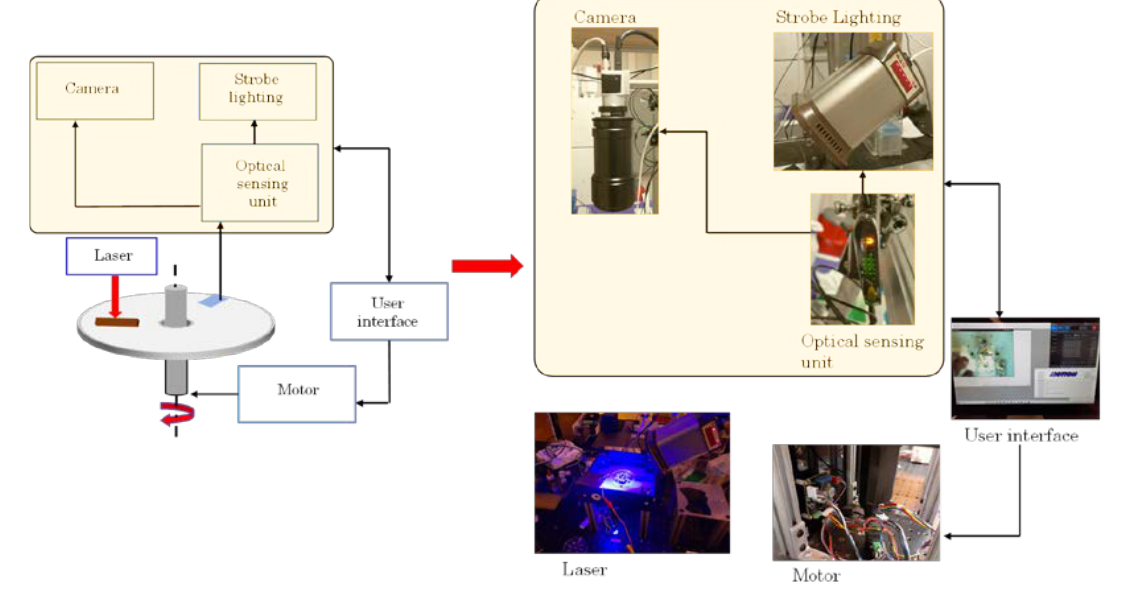
Figure 4. The experimental setup for testing the integrated CD consisting of the spin chuck that is spun by a motor and the motor is connected to the controller that gets its input for angular velocity and acceleration via graphic user interface on the computer. The optical sensing unit receives a laser light reflected from a piece of reflecting tape secured to the CD and this light serves as a signal to open the shutter to take a picture with digital camera and to shine the stroboscopic light to add illumination for taking the picture. This sequence of photographs (one per disc’s revolution) is recorded as a video that is captured from a computer screen using recording software Bandicam (Bandicam Company, Irvine, CA, USA). Reproduced from [12,15].